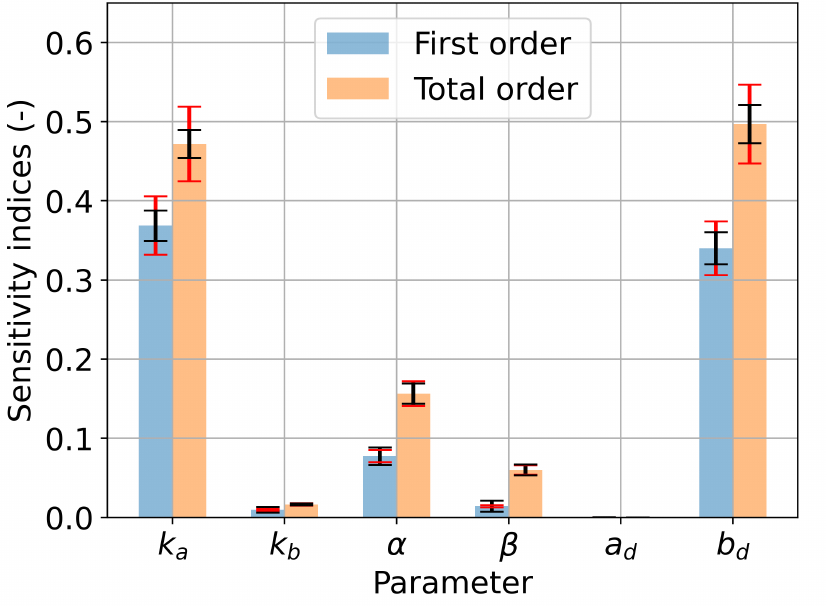
Figure 4. The Sobol sensitivityindices for a turbine spacing of 4.8 D , including the 95% confidence interval error bar ( black ) and the 10% deviation ( red